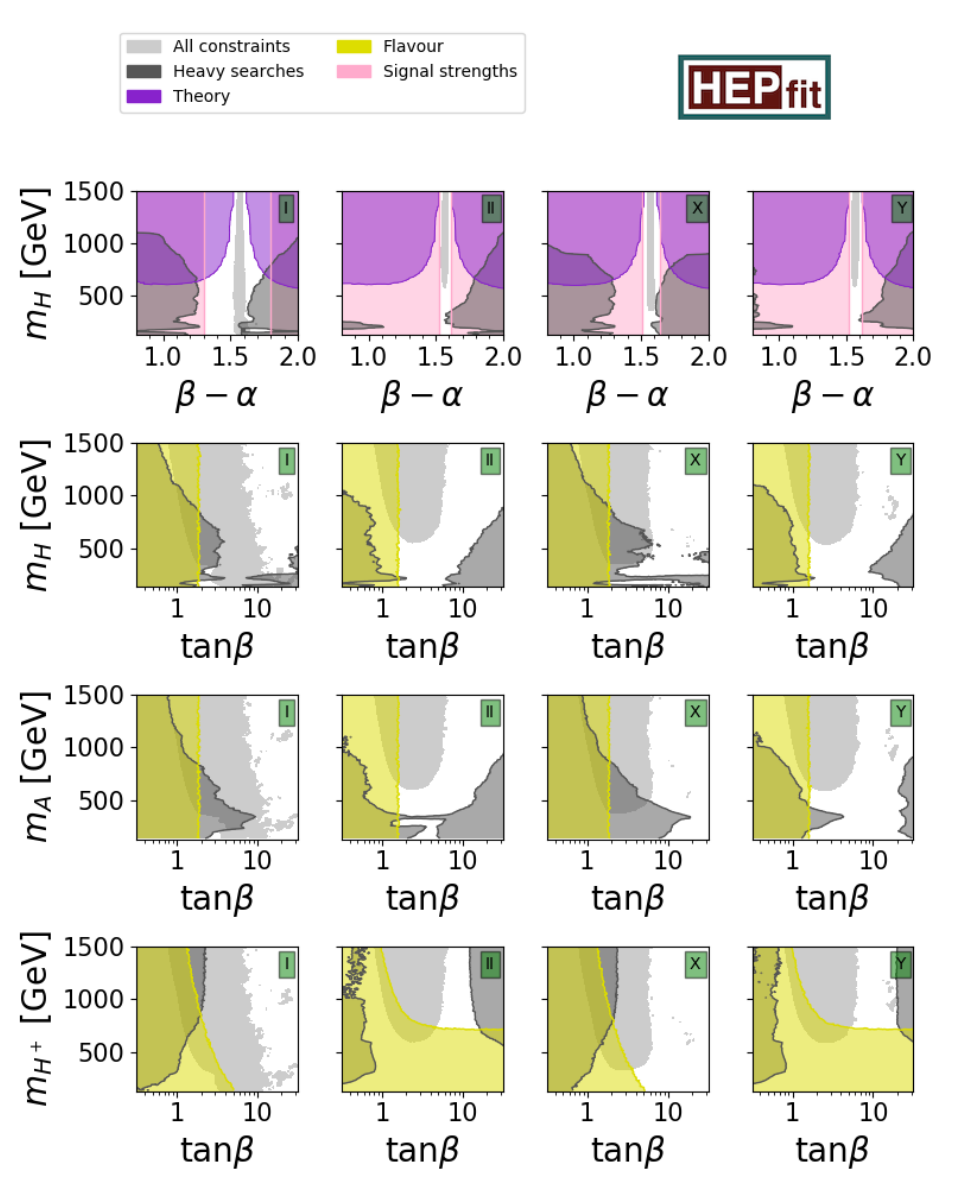
Figure 4 . In the 2HDM mass vs. angles planes we display the regions allowed by all constraints with a probability of 95.4% in light grey and compare them with the areas excluded by various sets of bounds: the 95.4% contours of heavy Higgs searches (dark grey), (cid:13)avour observables (yellow) and h signal strengths (pink) as well as the 99.7% limits from theory constraints